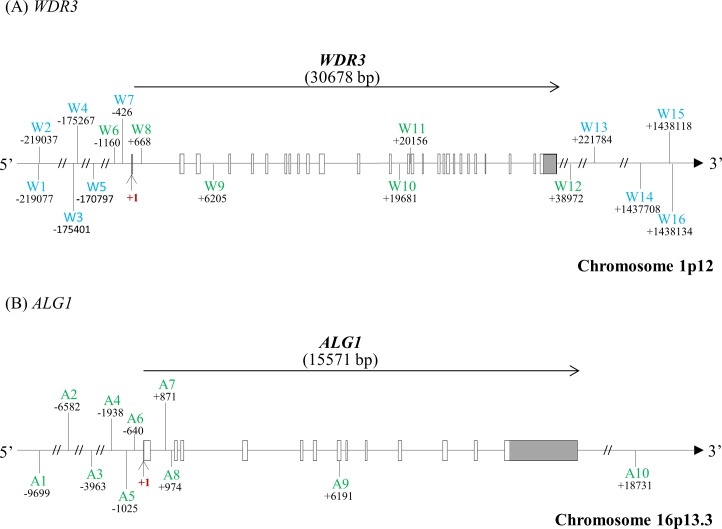
Genomic structure of human WDR3 and ALG1.Genomic structures and positions of the SNPs in human WDR3 (A) and ALG1 (B). Exons are denoted by boxes with untranslated regions in gray, and translated regions in white. SNPs denoted in light blue are located in the CTCF binding site, and in green are the tag SNPs (correlation coefficient: r2>0.85, minor allele frequency: MAF>0.10).